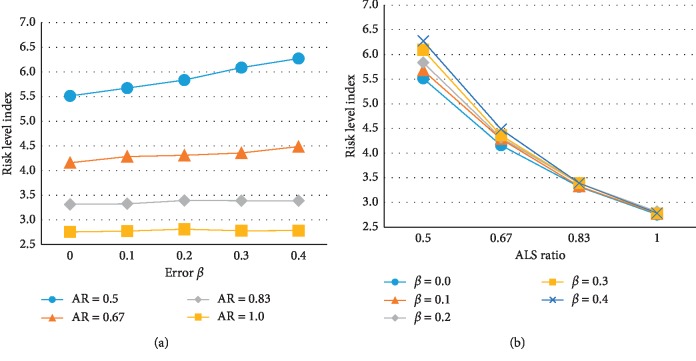
Interaction effect of ALS ratio and error β on the risk level index.